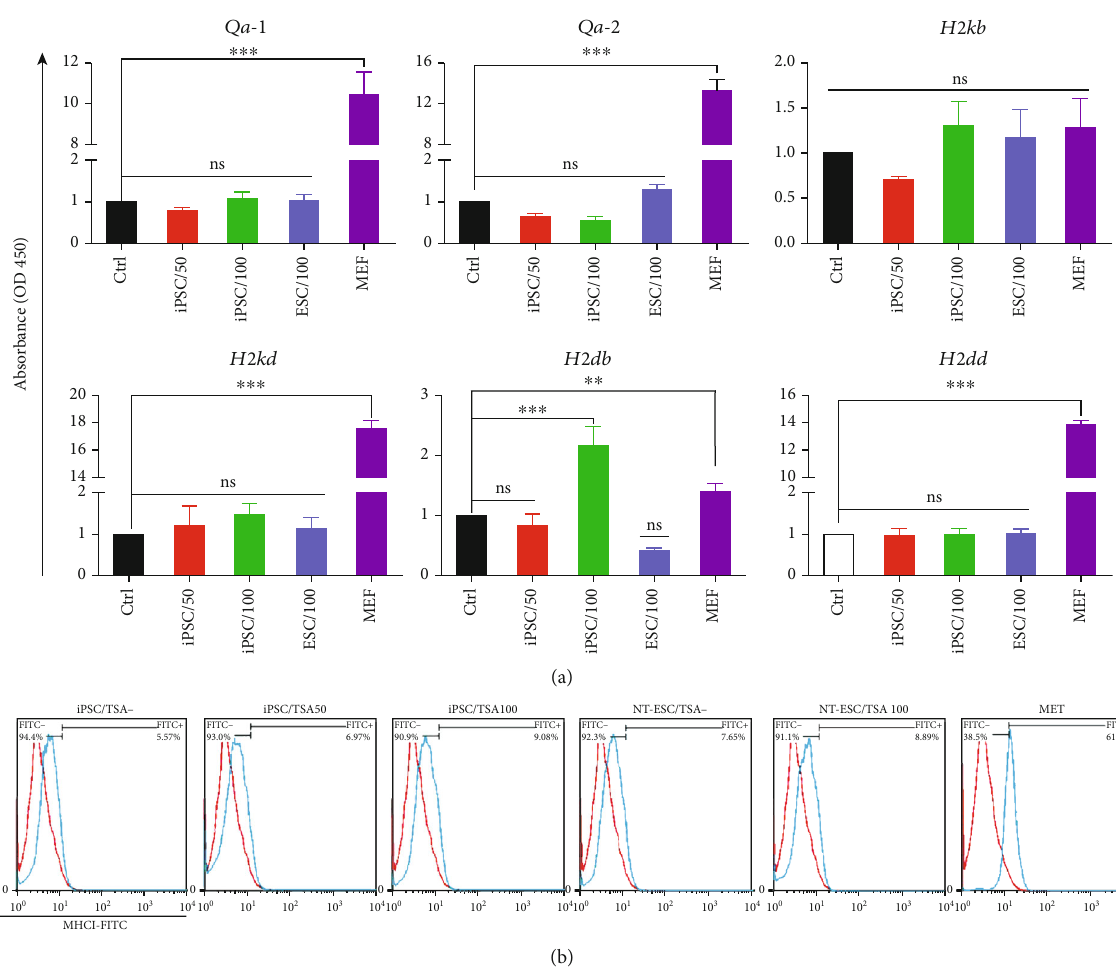
Figure 4: MHC class-I expression level. (a) Histograms shows the real-time PCR analysis of Qa-1 , Qa-2 , H2kb , H2kd , H2db , and H2dd in TSA-treated ESCs and iPSCs vs. nontreated control groups and parental MEF cells. (b) Flow cytometry analysis of the expression of MHC I molecules on the surface of ESCs, iPSCs, and MEF cell. ns: not signi fi cant; ∗∗ and ∗∗∗ indicate the statistical signi fi cance, P < 0 : 01 , P < 0 : 001 , respectively, compared to the control